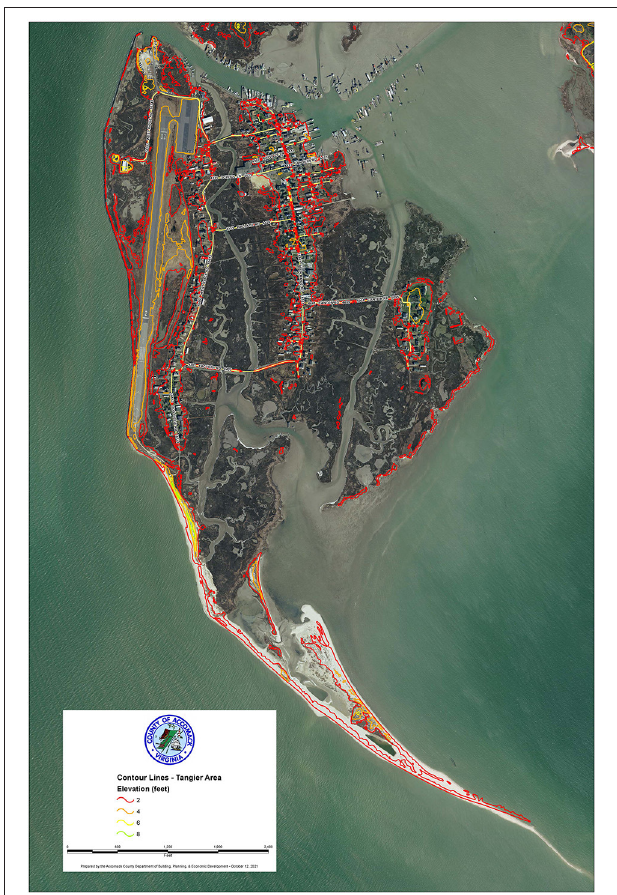
FIGURE 7 | LIDAR survey of the southern portion of Tangier Island and the Town of Tangier (2 feet = 0.61m, 4 feet = 1.22m, 6 feet = 1.83m). Source: Accomac County. Imagery is from